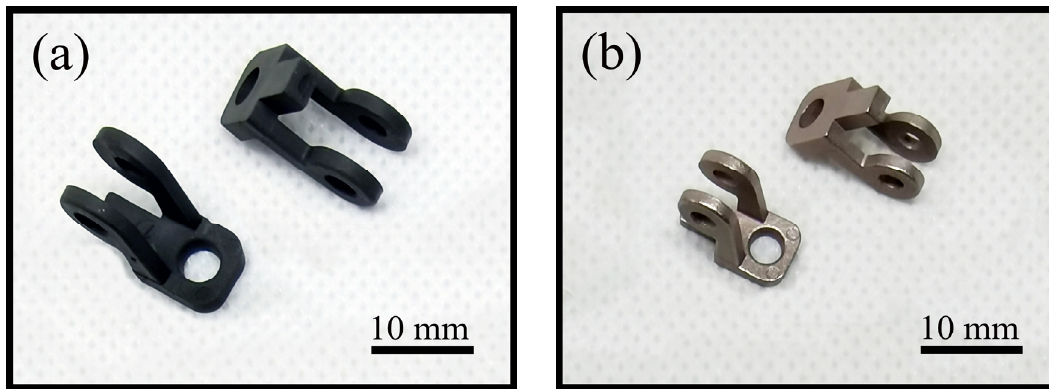
Materials 2021 , 14 , x FOR PEER REVIEW Figure 5. Supporter parts produced via powder injection molding (PIM) ( a ) green part; ( b ) sintered part.